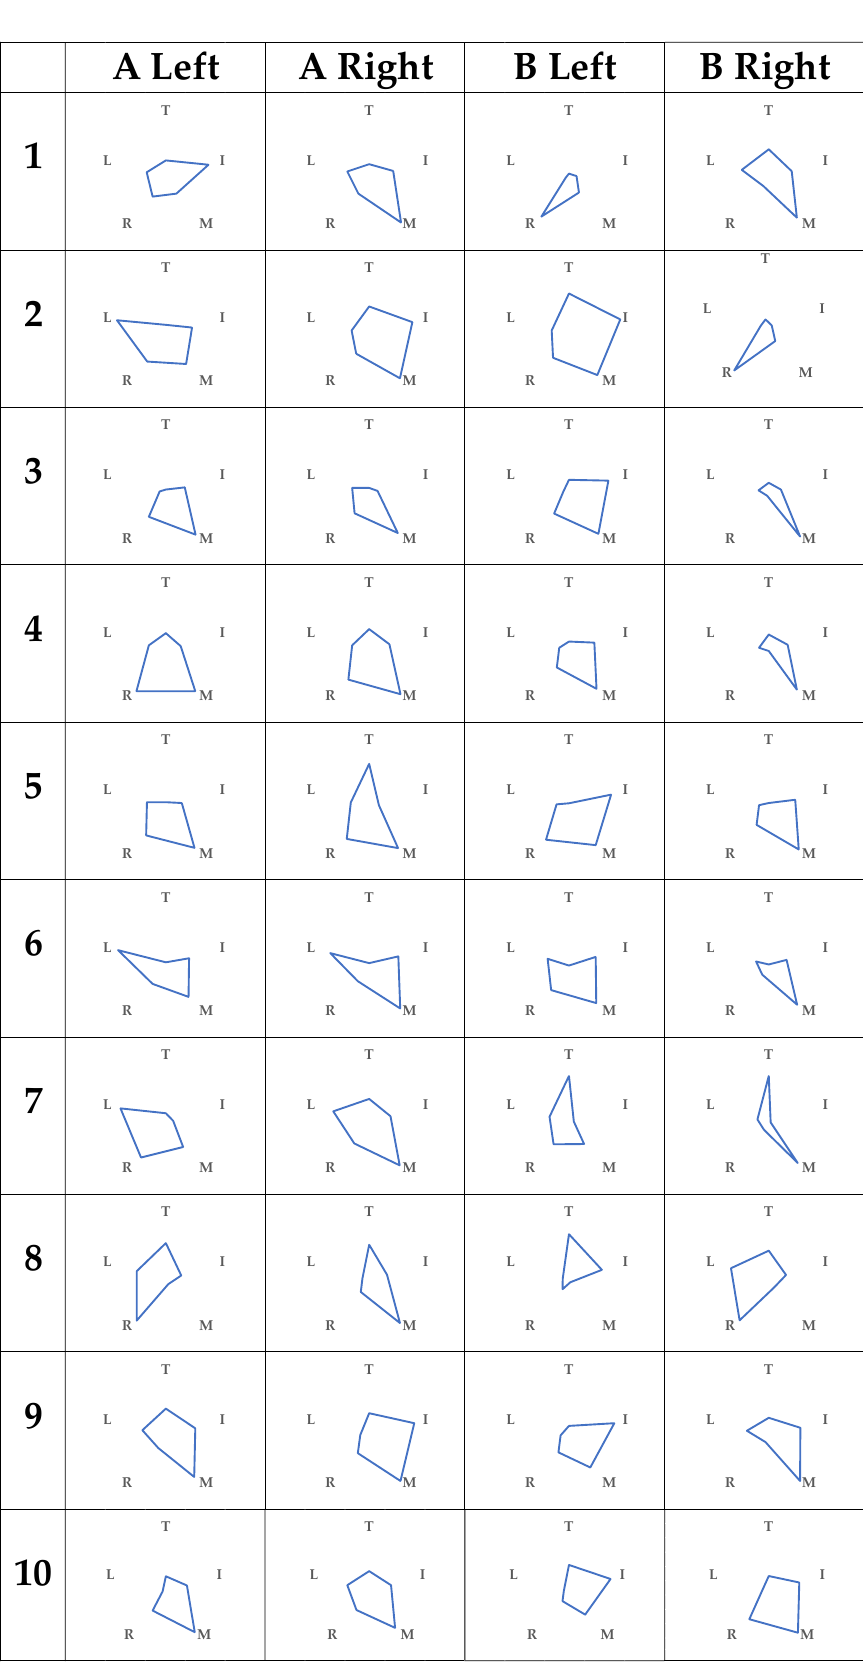
Figure 5. Radar charts of raw contact-force